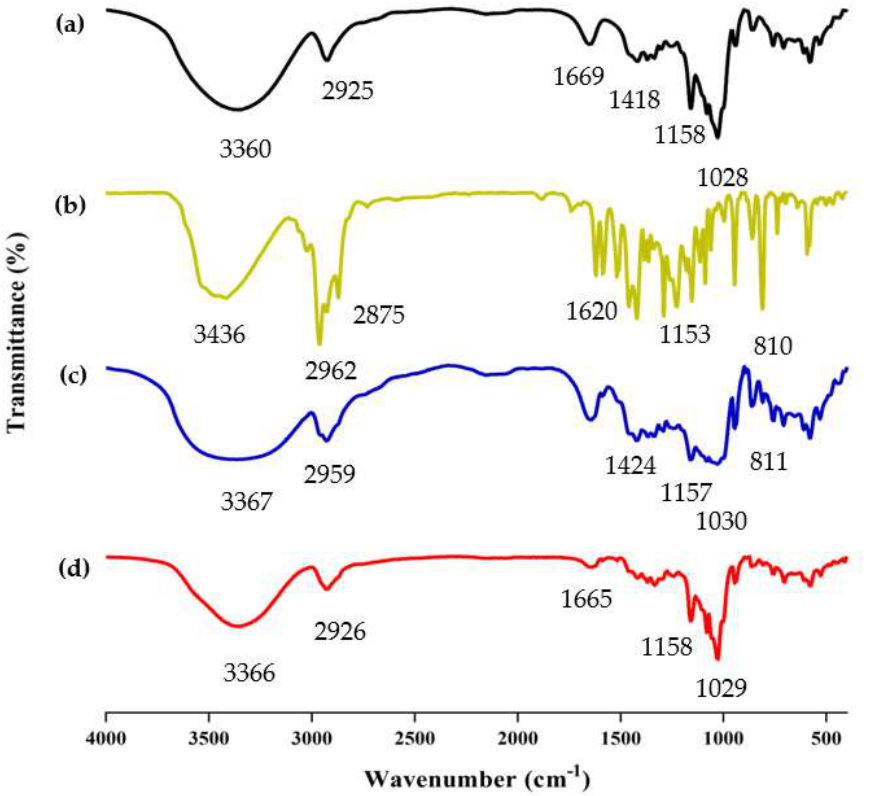
Figure 4. The results of FT − IR spectra. ( a ) β − CD; ( b ) EO; ( c ) PM; ( d ) β − CD/EO IC.